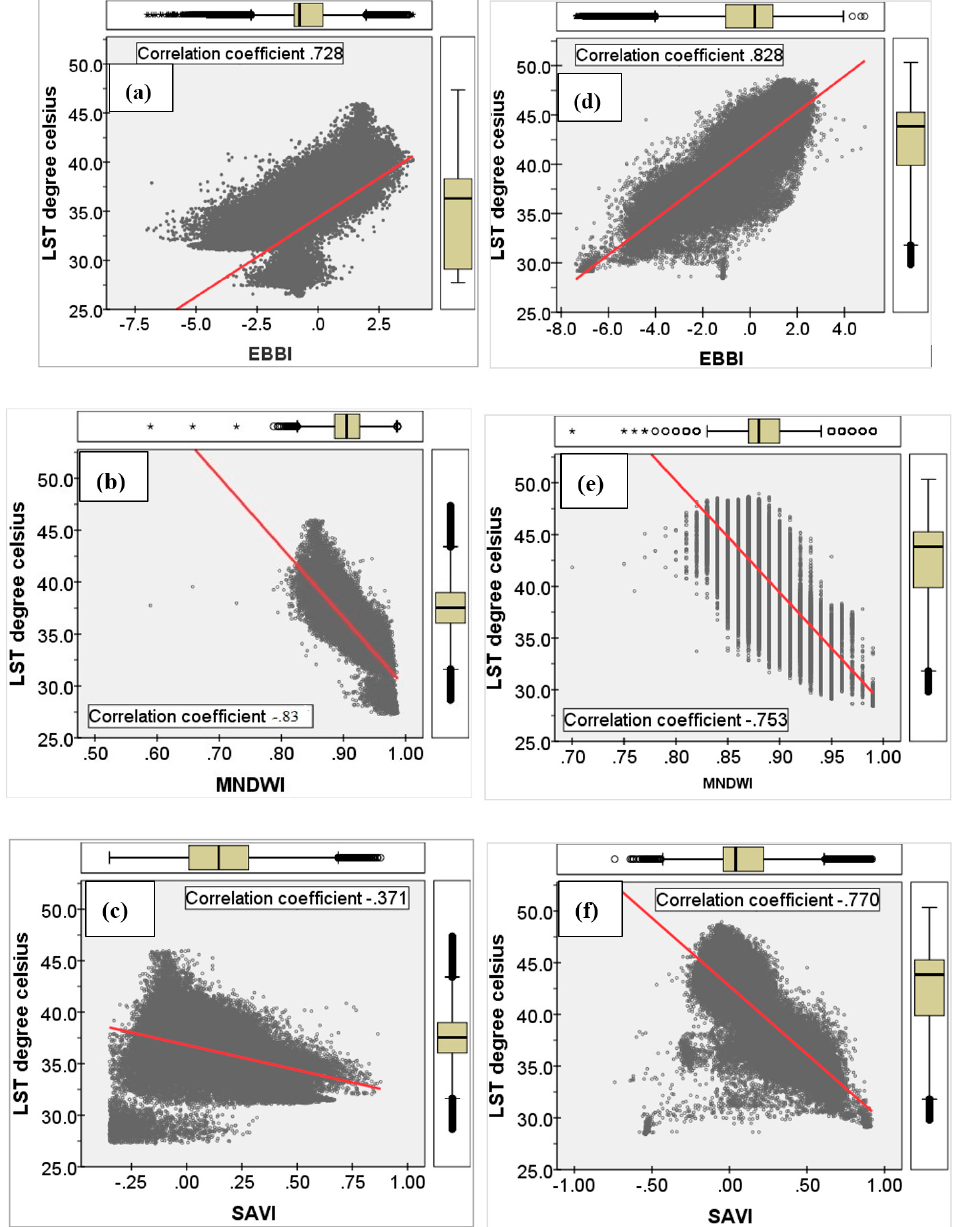
Figure 7. Correlation coefficient values between LST (dependent variable) and other indices (independent variables) obtained through the analyses of data from Landsat OLI for Panaji ( a ), ( b ), ( c ) and Tumkur ( d ), ( e ), ( f